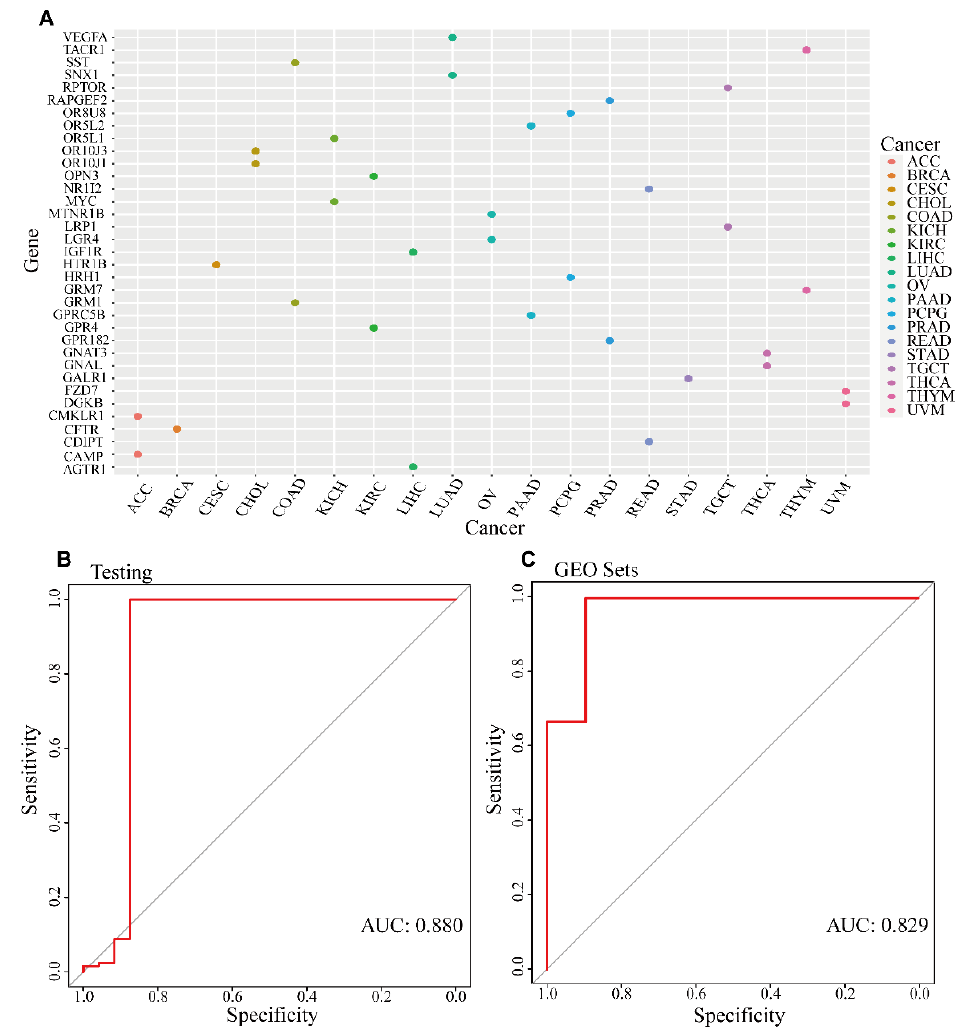
Figure 3. GRSDMs recognition and model establishment. ( A ) GRSDMs in pan-cancer; ( B ) Random forest model performance in the test set; ( C ) Random forest model performance in the GEO validation set.